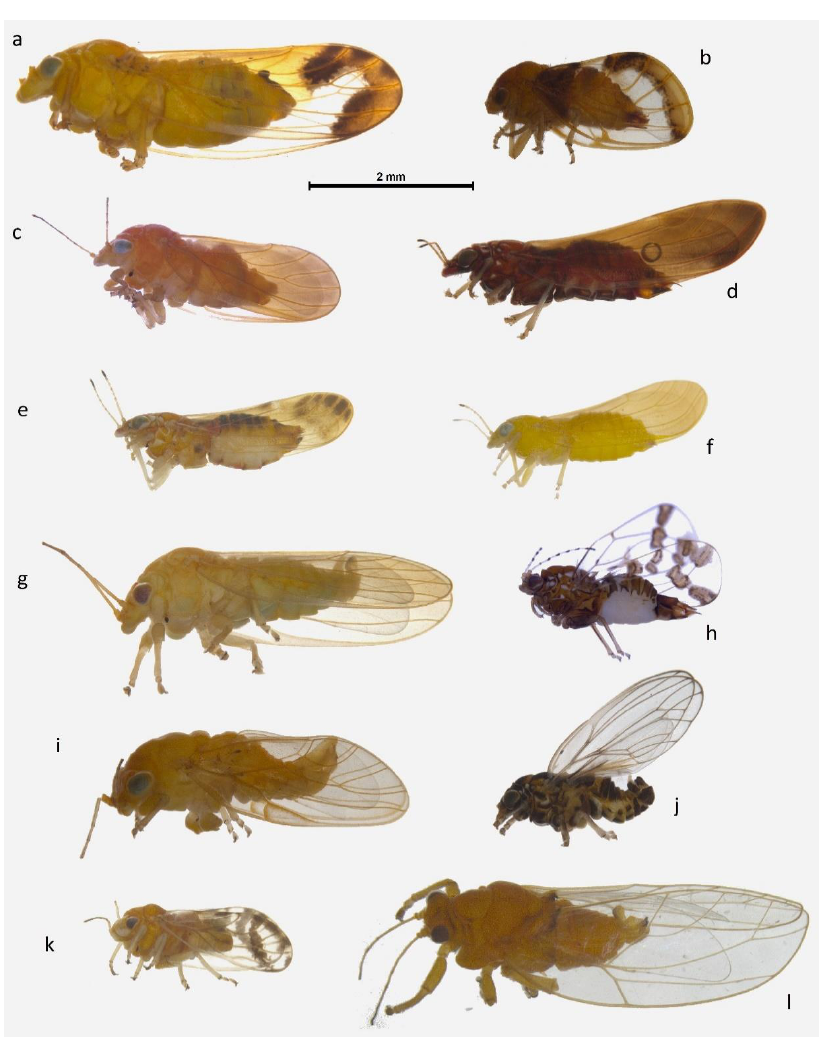
Figure 3. Examples of diversity in forms and colors of the psyllids collected. Blepharocosta sp. B ♀ ( a ), Insnesia sp. A ♀ ( b ), Creiis sp. L ♀ ( c ), Anoeconeossa sp. B ♀ ( d ), Anoeconeossa sp. D ♀ ( e ), Anoeconeossa sp. H ♀ ( f ), Creiis sp. J ♂ ( g ), Pseudophacopteron sp. A ♀ ( h ), Phellopsylla sp. C ♂ ( i ), Phellopsylla sp. I ♂ ( j ), Acizzia sp. A ♂ ( k ), Schedotrioza sp. A ♂ ( l ). Scale bar is 2mm.